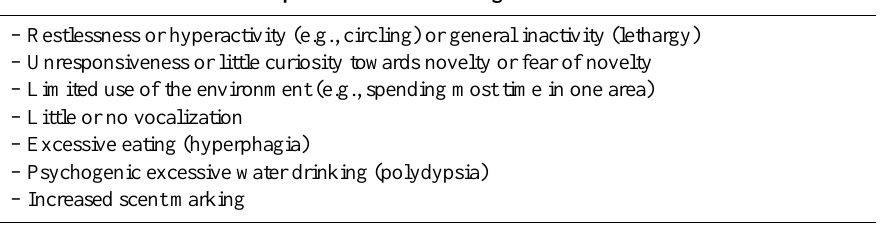
Table 1. Behaviours that may indicate poor welfare in primates (NB: not all behaviours are applicable to all species). Adapted from JWGR